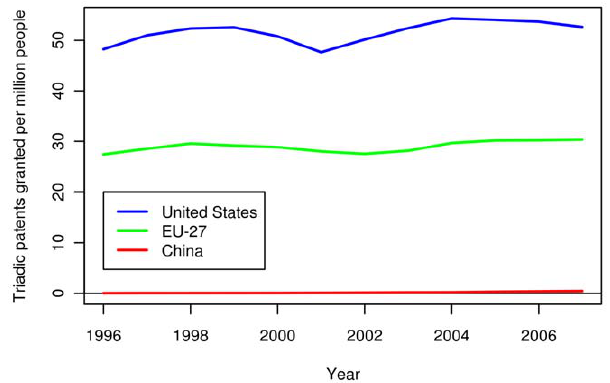
Figure 14. Published papers per capita by researchers in the US, the EU-27 and China. Papers from journals included in the Science Citation Index and the Social Sciences Citation Index were enumerated. Each region received a fractional count based on the fraction of the institutions in the region. The number of papers was divided by the size of the population of each region.